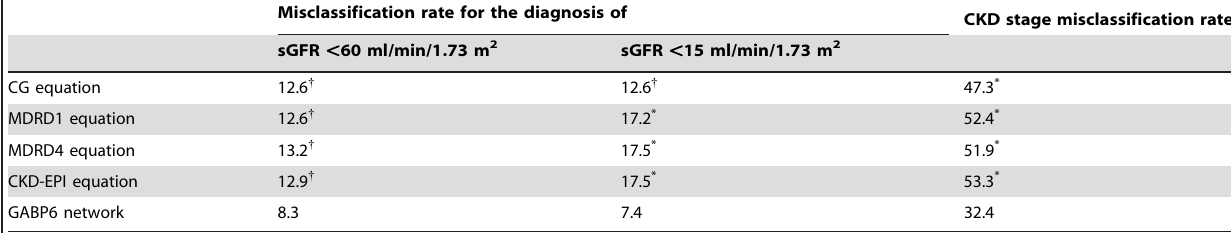
Table 4. CKD Misclassification in the external validation data set.